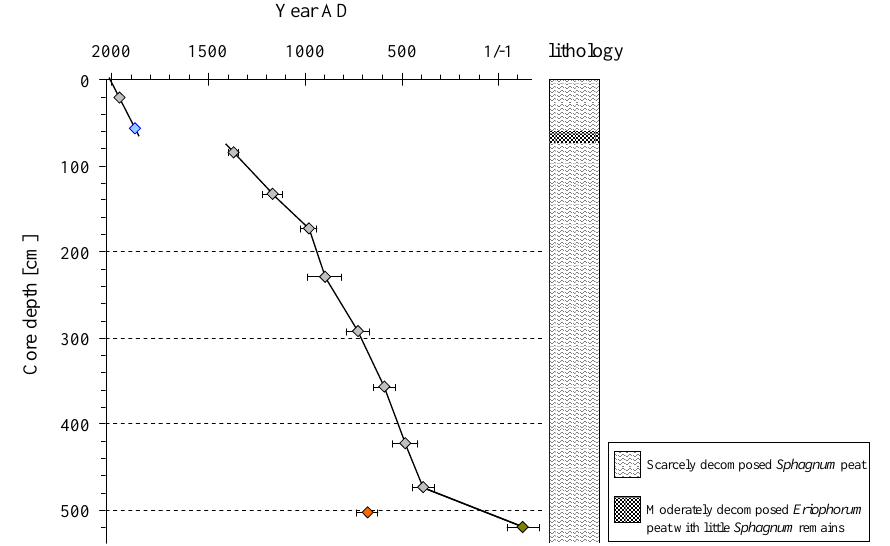
Fig. 4. Age-depth model and lithology of core DM-01 taken in the centre of the D¨urres Maar peat deposit. The model is based on 10 14 C results calibrated and transformed to calendar ages (years AD) using CALIB 5.0 (Reimer et al., 2004). The age at a depth of between 56 and 58 cm (blue diamond) is determined on the basis of the palynological investigation performed on selected samples of the profile (for details see Sect. 5.1). The sample from a depth between 502 and 504 cm was omitted from the model, since its 14 C age is obviously too young. In one case (dark green diamond) plant fragments from Vaccinium spec. were used for 14 C dating, because Sphagnum plant material was not available in an adequate